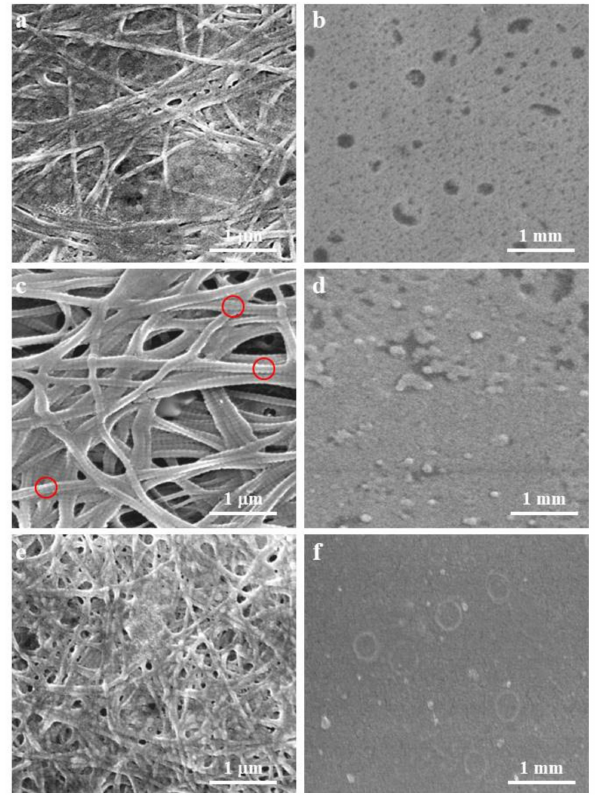
Figure 6. SEM images of collagens from grass carp skin, grass carp scales, and crucian carp skin. ( a ), ( c ) and ( e ) show the SEM images of the GCC, GSC, and CCC collagen after self-assembled for 10 h in a 30 ◦ C salt solution. ( b ), ( d ) and ( f ) show the SEM images of the GCC, GSC, and CCC collagen after drying at room temperature. The red circles indicate the periodic ring D band of